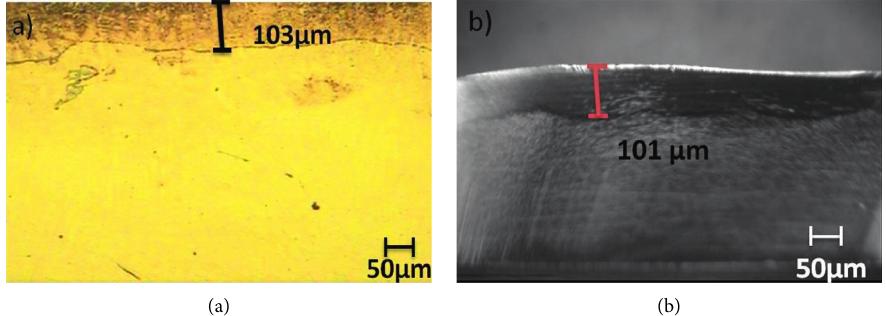
Figure 5: Micrographs of the coatings obtained by HVOF (a) and (b).